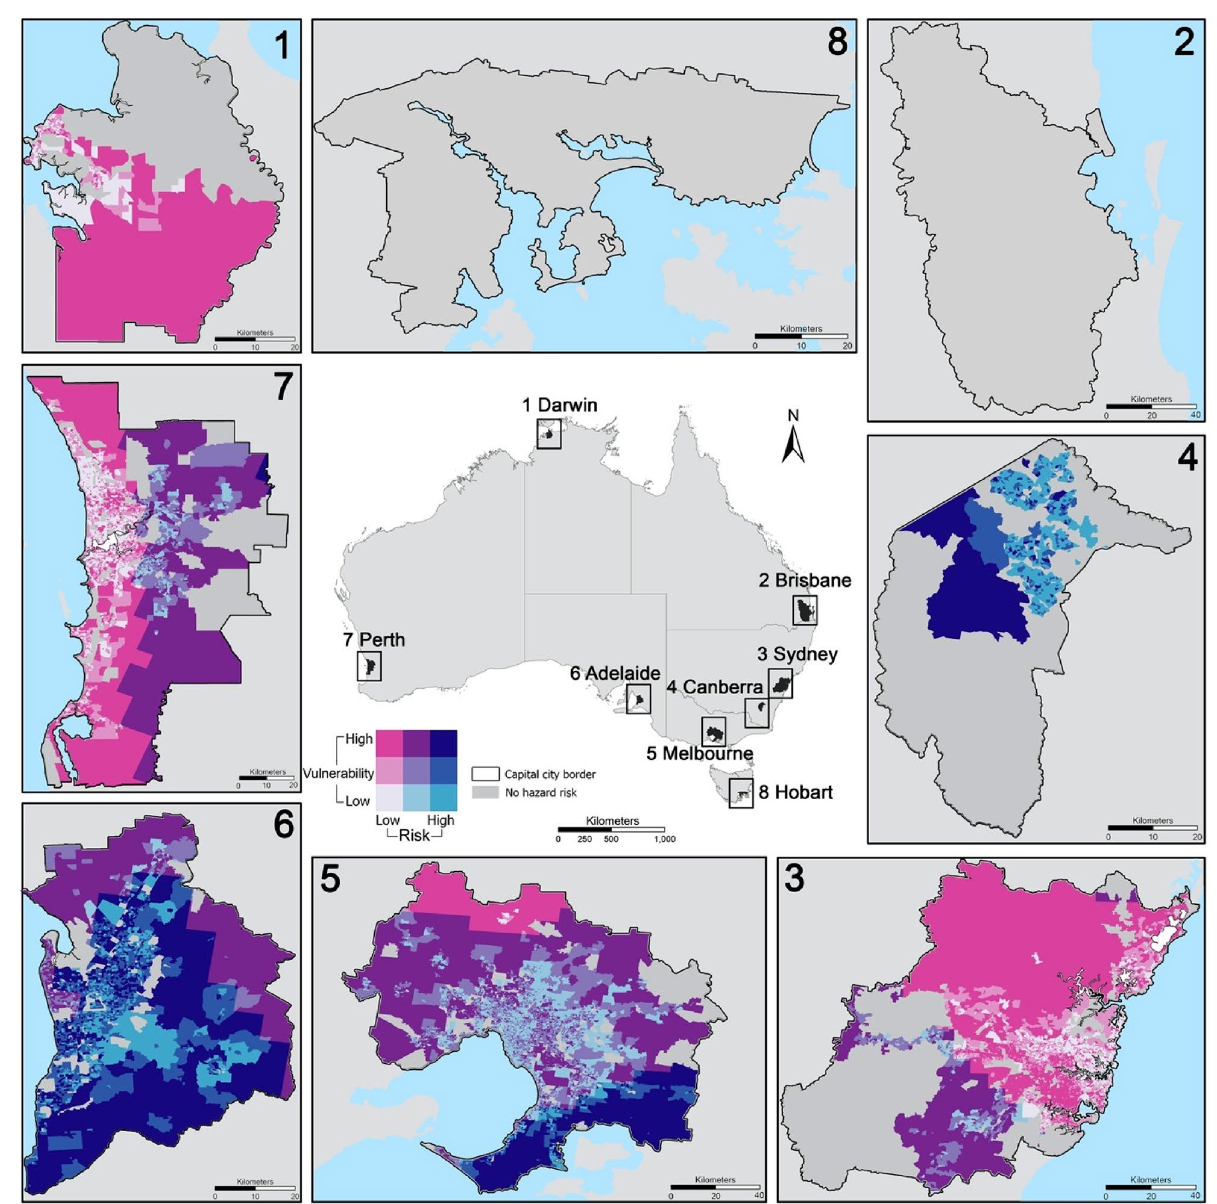
Figure 7. The enlarged capital city map showing the most vulnerable areas highly risky in earthquakes. Hobart and Brisbane have no earthquake-affected areas. The most vulnerable areas highly risky in earthquakes (dark blue areas) appear in the southwest of ACT, the south coastal areas of Melbourne along the Western Port Bay as well as occupy the major areas of Adelaide; while the highly vulnerable areas in the east of Perth, the south of Sydney and the south of Darwin though they are not subject to high levels of earthquake risks. In addition, there are no earthquake-affected areas Hobart and Brisbane. The spatial patterns of most vulnerable areas highly risky in wildfire and flood are displayed in Supplementary Figs. S8 and S9; the names of these vulnerable areas are detailed in Supplementary Note 5 and Table close to and/or on the urban fringe, where must be prioritized for adaptation; while the most vulnerable areas in rural regions are observed in the remote inland and culturally protected areas (e.g., indigenous protected areas in Northern Territory). The spatial patterns of vulnerability substantially vary across space and five themes. Our measures of vulnerability supplement the SEIFA indexes developed by ABS given it captures not only the demo- graphic and socioeconomic profiles of the Australian population, but also features of housing, transport, and built environment. End users (e.g., government, public and private sectors, environmentalists, and academics) can be able to apply the theme-specific vulnerability index in various contexts and for distinct purposes (e.g., using Theme 4 of housing and transportation in the designation of housing insurance). Our results contribute to profiling Australia’s vulnerability and hazard risk assessment, and provide quantitative evidence for place-based risk reduction and sustainable urban–rural development.